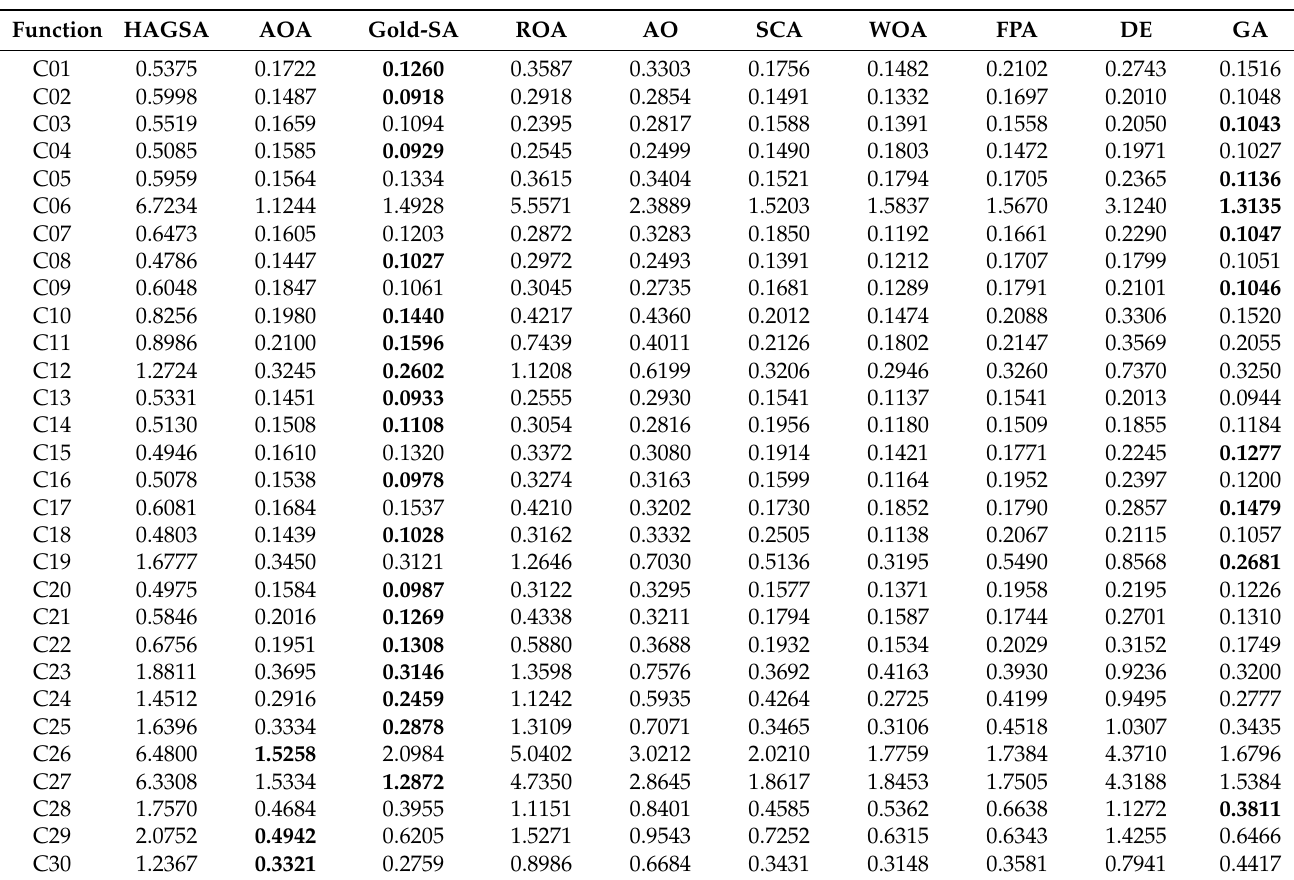
Table 5. The computational time for HAGSA and its peers.